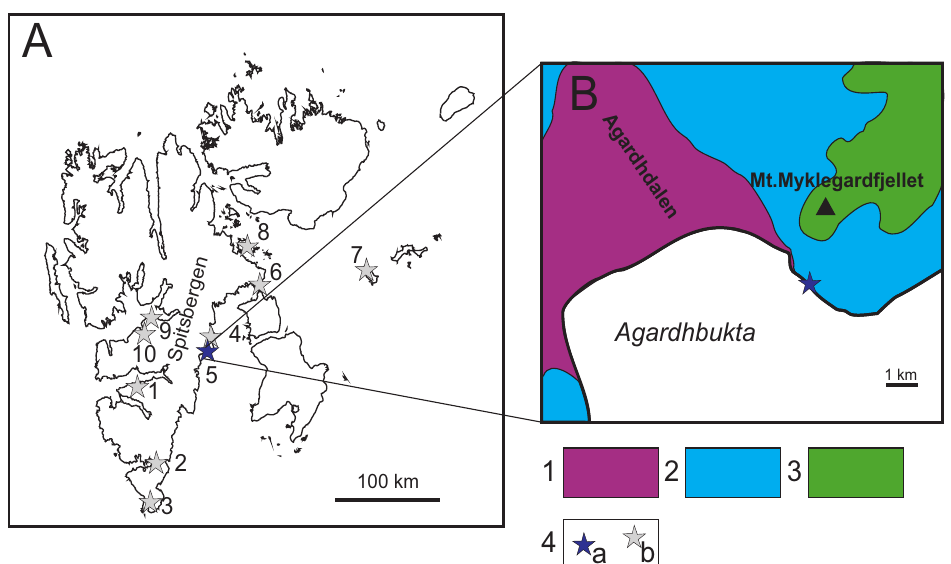
Figure 1. Outcrops with Toarcian fossils on Svalbard mentioned in this paper. (A) General overview map of Svalbard,